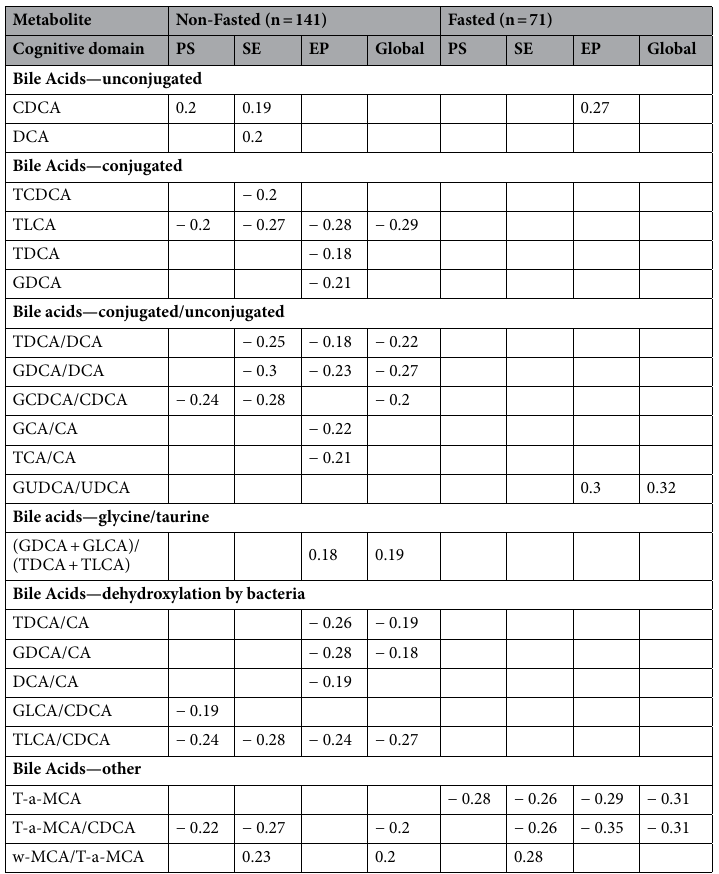
Table 2. Spearman’s rank order correlations between serum bile acids and cognitive domains. PS perceptual speed, SE semantic memory, EP episodic memory, Global global cognition. The numbers represent Spearman’s ρ with the p value < 0.05 and FDR corrected with the q = 0.2. Full names of all identified compounds are presented in the Supplemental Table S2 and correlation for all cognitive domains are presented in the Supplemental Table